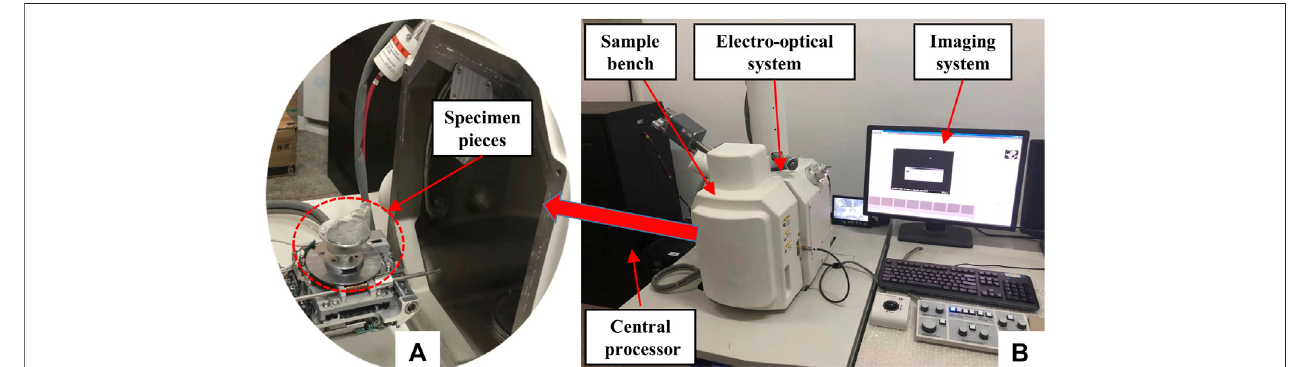
Frontiers in Materials |